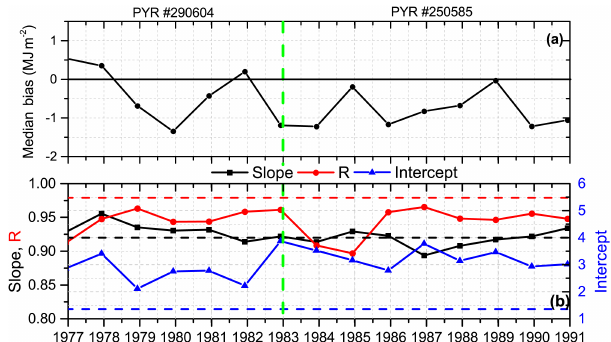
Figure 6. (a) Time series of the median bias between PYR GSR H and CS-AP GSR H inMJm − 2 , and (b) time series of the slope (black line), correlation coefficient (red line; R ) and intercept (blue line) for each year. The black, red and blue dashed lines indicate the slope, R and intercept obtained in the period 2014–2015, respec- tively (see Fig. 3). The green dashed lines represent the instrument change in